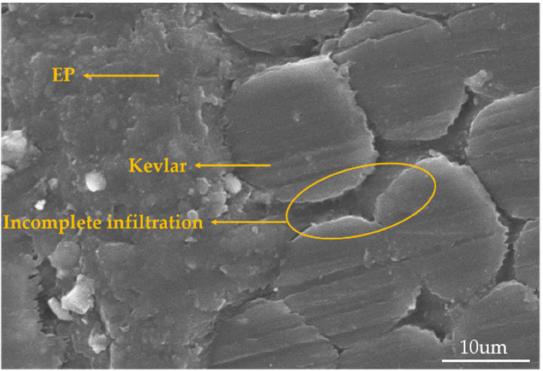
Figure 8. SEM morphology of the cross-section of 3D armor material.